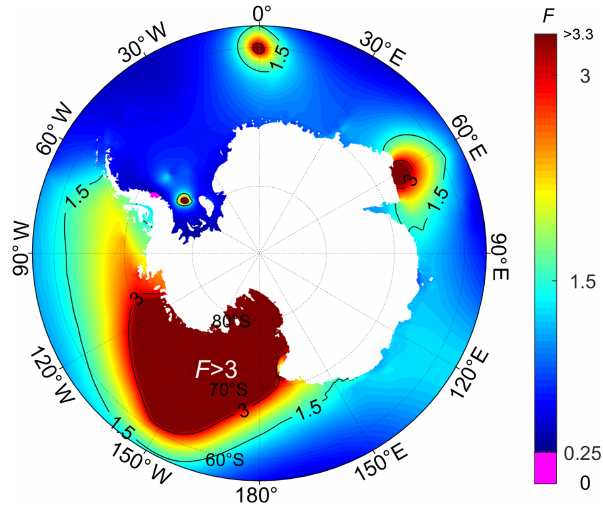
Figure 9. Distribution of tidal form factor ( F ) values around Antarctica. Note the magenta area (72 ◦ S) on the Antarctic Penin- sula’s Weddell Sea coast denotes the only area with a properly semidiurnal tide regime ( F < 0 . 25) in the Antarctic